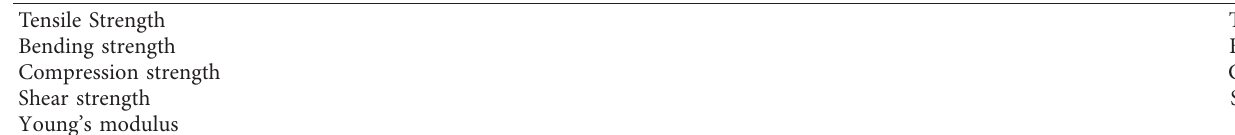
Figure 7: (a, b) Tensile specimens before and after testing. Table 6: Mechanical property notations.